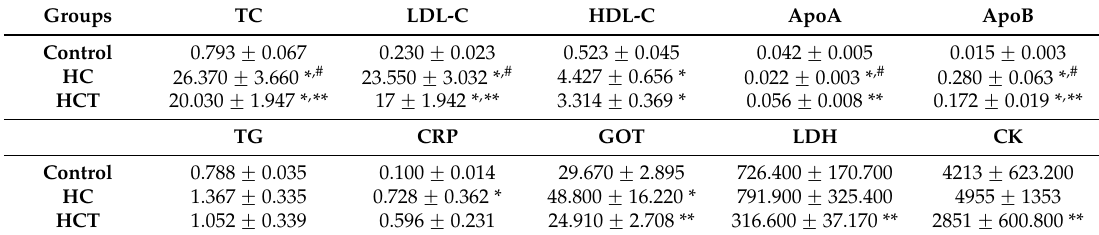
Table 2. Serum biomarkers of cardiac function. Average serum TC, TG, LDL-C, HDL-C (mmol/L), ApoA and ApoB (g/L), CRP (mg/L), GOT, LDH and CK (U/L) levels in 3 groups of rabbits ( n = 6), were analyzed by an automated hematology analyzer. Each analysis was conducted on peripheral blood serum harvested from animals following the 8-week treatment periods, for: non-hypercholesterolemic (control), hypercholesterolemic rabbits (HC) and hypercholesterolemic animals receiving WGLL-supplemented chow (HCT). Results are shown as the average values from each group of animals ˘ SEM of serum total cholesterol (serum cholesterol, mmol/L) and low-density lipoprotein cholesterol (LDL-C,